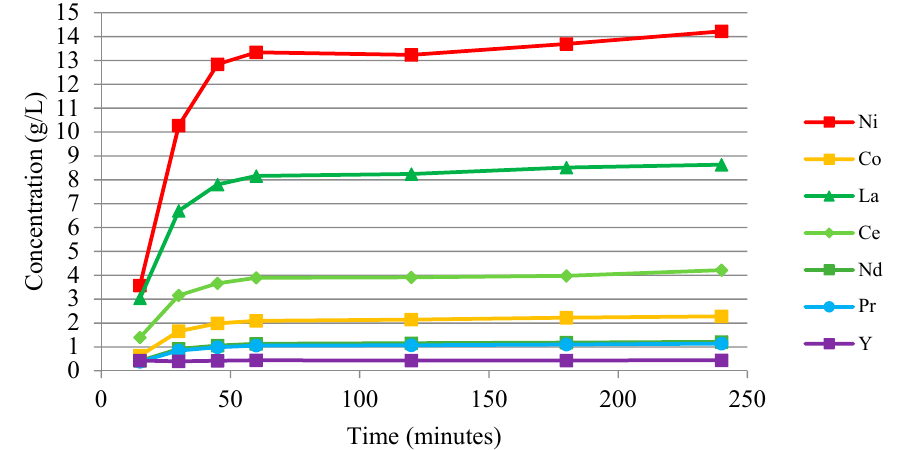
Figure 6. Leaching of anode material with 1 mol/L hydrochloric acid at 25 °C .